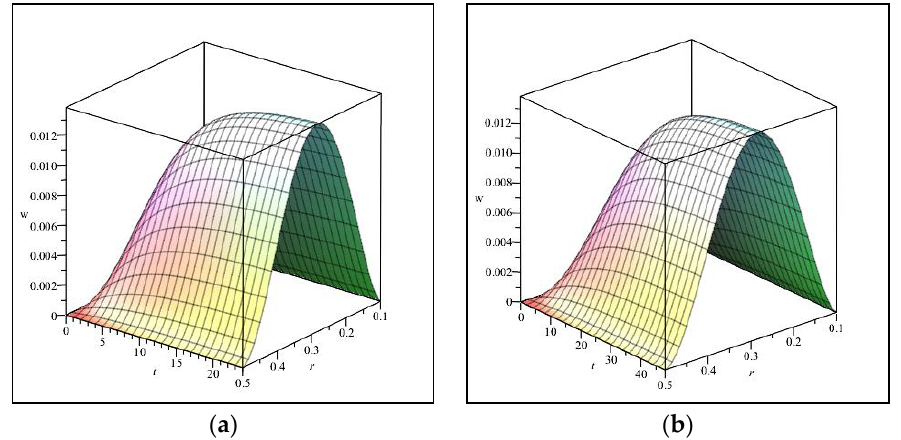
Figure 9. Deflection changes versus 𝑟 and time for ( a ) 𝑔 = 5 and ( b ) 𝑔 = 10 .